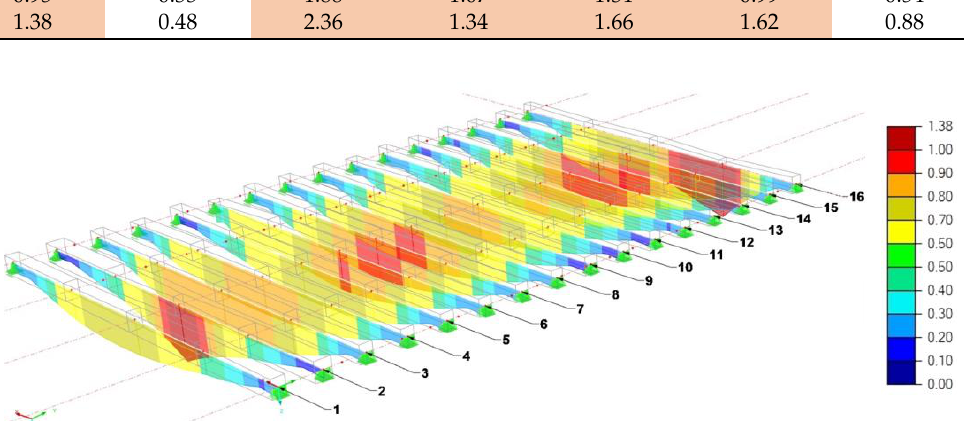
Figure 23. ULS diagram of the different beams of the floor (% of the maximum capacity). The sections marked in red among the beams indicate reaching 90% of the structural capacity.